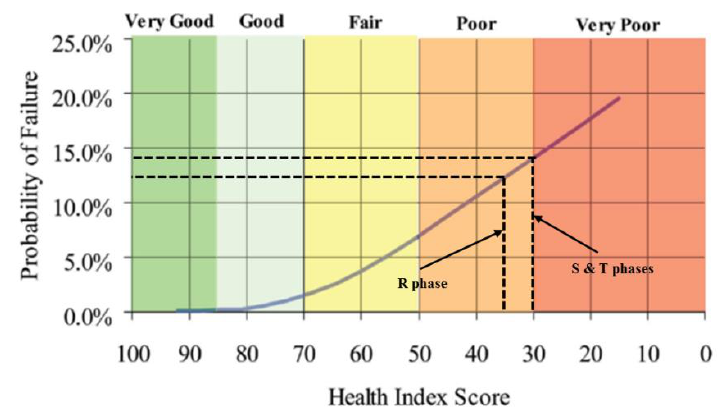
Figure 8. Standard probability of failure versus OHI curve [48].